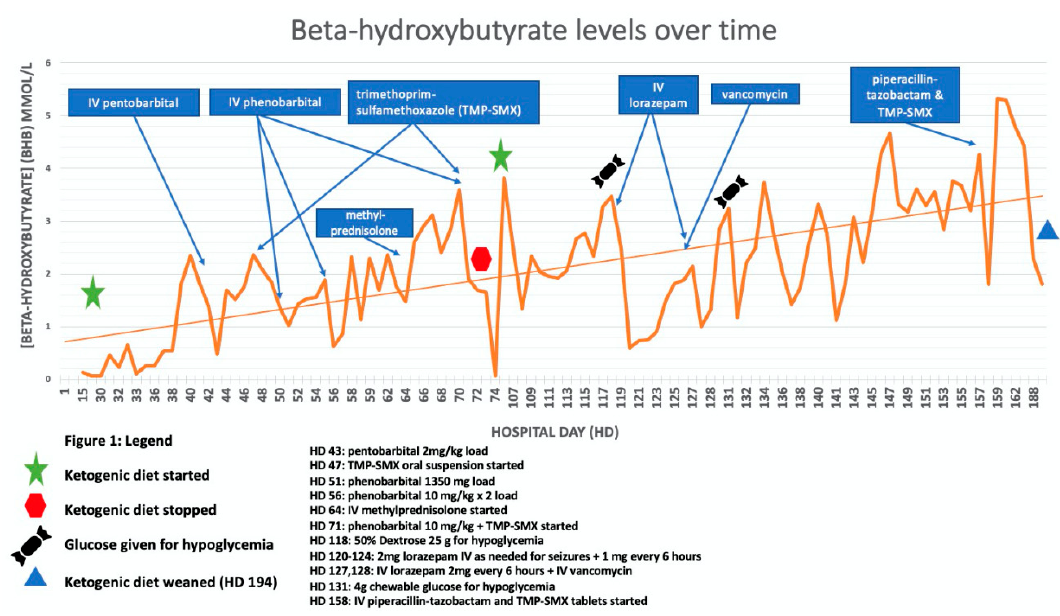
Figure 1. Drug Interference with achievement of ketosis. Seizure Activity: On HD 14–16, seizure burden was 90% noncon- vulsive status epilepticus (NCSE) and decreased to 10–15% by hospital day (HD) 23–24. From HD 30–39, % ictal ranged from 5–20% with HD 40 showing <1% ictal. % Ictal increased briefly during HD 41–47 with an average of 15% ictal but decreased to <1% by HD 48/49. % Ictal remained in the 10–20% range until HD 57 with % ictal < 1. From HD 58–72 % ictal ranged from 5–20% until % ictal <5 by HD 72.